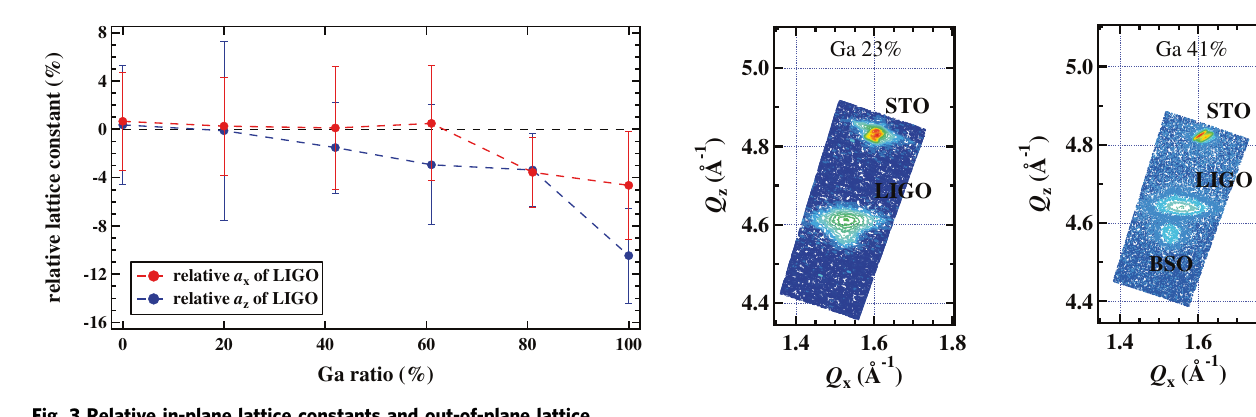
Fig. 3 Relative in-plane lattice constants and out-of-plane lattice constants obtained from STEM as a function of the Ga alloying ratio.